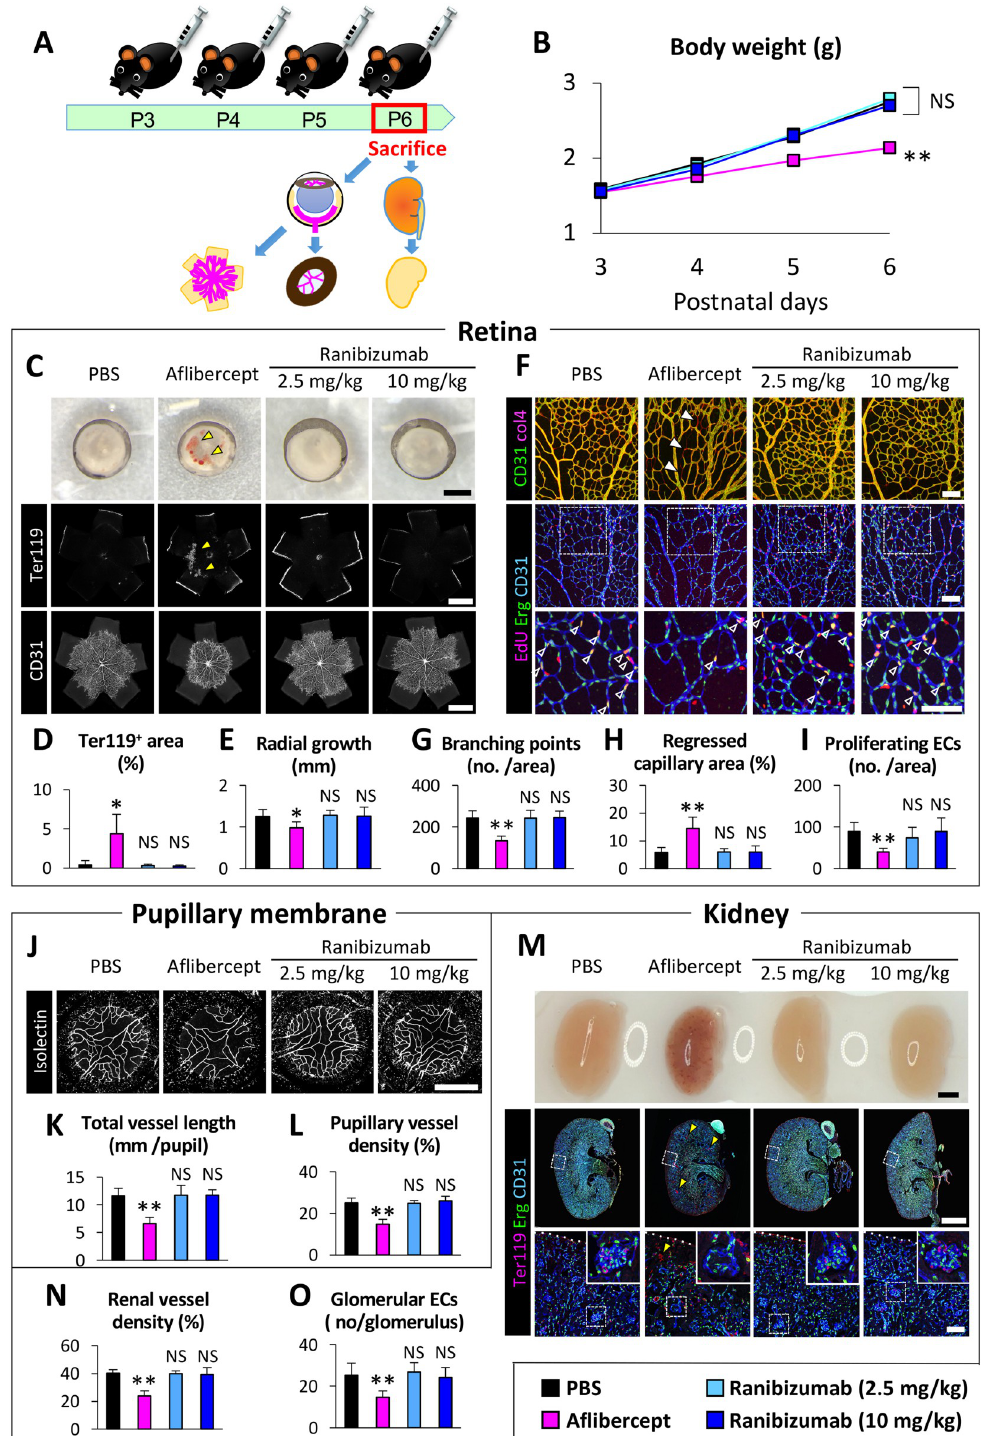
Fig 2. The effect of ranibizumab and aflibercept injected intraperitoneally into neonatal mice. (A) A schematic diagram depicting the time course of our experiment. (B) The body weight gains were impaired in the aflibercept group but not in the ranibizumab groups. (C-E) The whole-mounted retinas showed apparent retinal hemorrhage (arrowheads) and vascular growth impairment in the aflibercept group but not in the ranibizumab groups. (F-I) The high magnification images of the whole-mounted retinas show decreased number of branching points, increased area of regressed capillaries